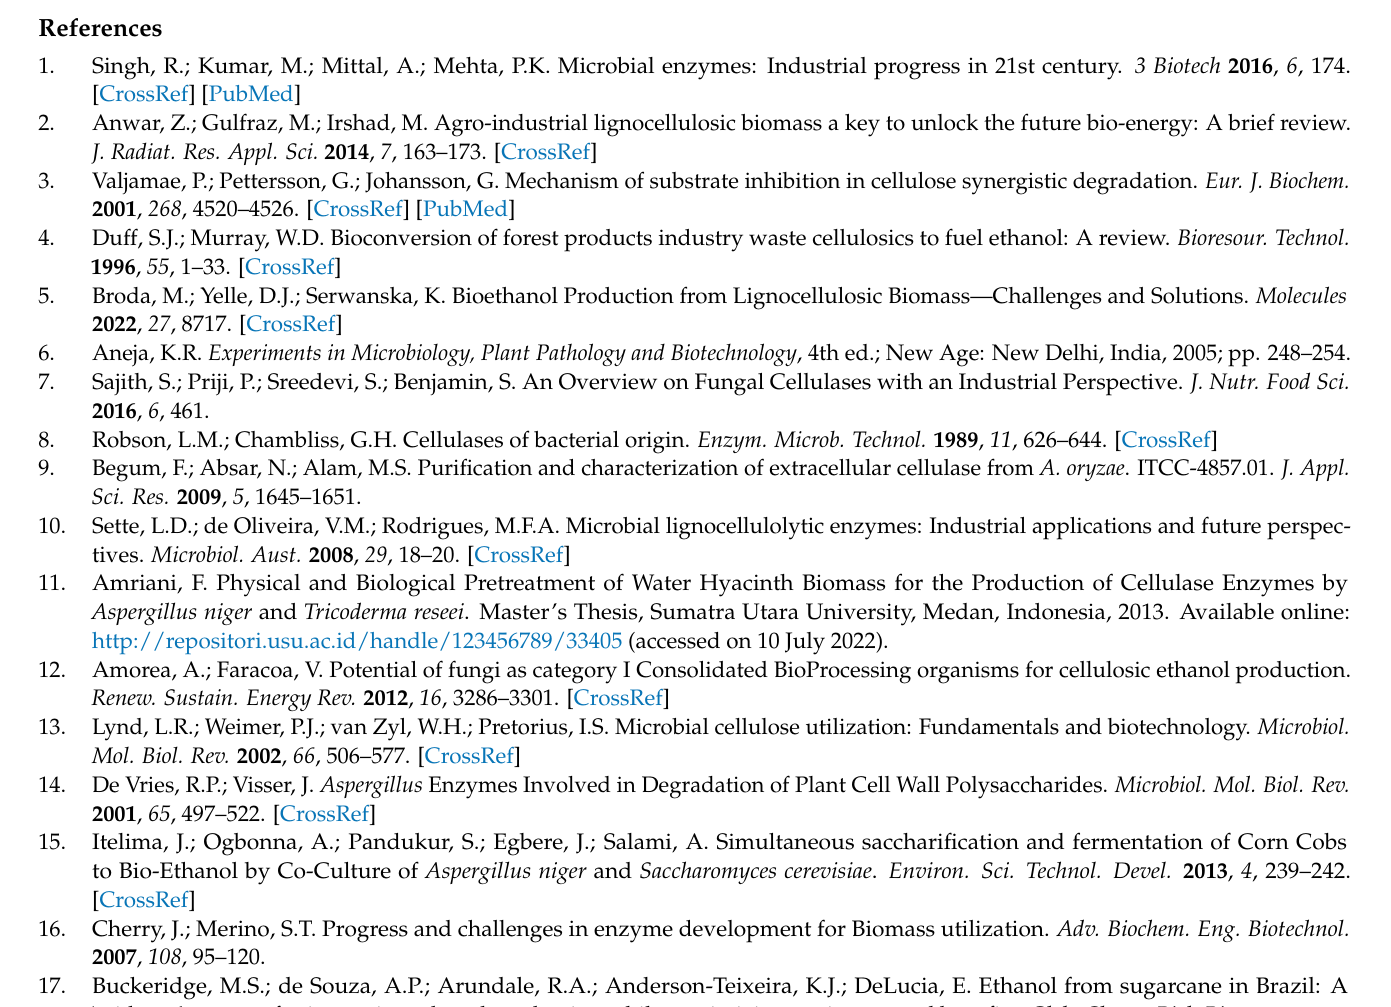
CMC-ase Production under SSF by A. niger MT328516 and A. flavus MT328429; Figure S9: The Effect of Nitrogen Source on CMC-ase Production under SSF by A. niger MT328516 and A. flavus MT328429; Figure S10: The Effect of Moisture Content on CMC-ase Production under SSF by A. niger MT328516 and A. flavus MT328429; Figure S11: The Ethanol Concentration (mg/mL) Produced by Fermented the Products of enzymatic hydrolysis of Wheat Bran and Coffee Pulp by A. niger MT328516 Using S.cerevisiae as Free or Alginate Immobilized Cells; Figure S12: The Ethanol Concentration (mg/mL) Produced by Fermented the Products of enzymatic hydrolysis of Wheat Bran and Coffee Pulp by A. flavus MT328429 Using S.cerevisiae as Free or Alginate Immobilized